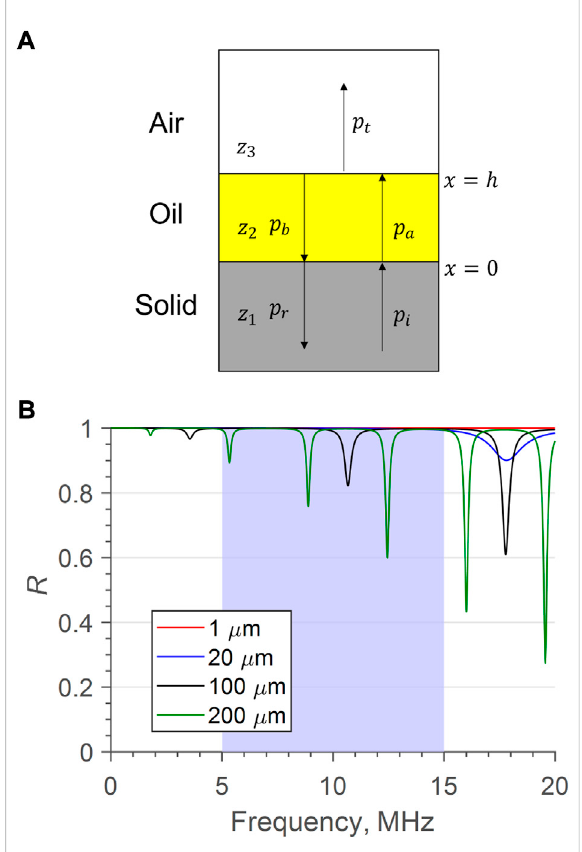
FIGURE 1 (A) schematic 3-body system showing the formation of transmitted and re fl ected waves. (B) Predicted Re fl ection coef fi cient using Eq. 6, resonances appear as dips in R . The blue region shows a typical usable bandwidth, centred around 10